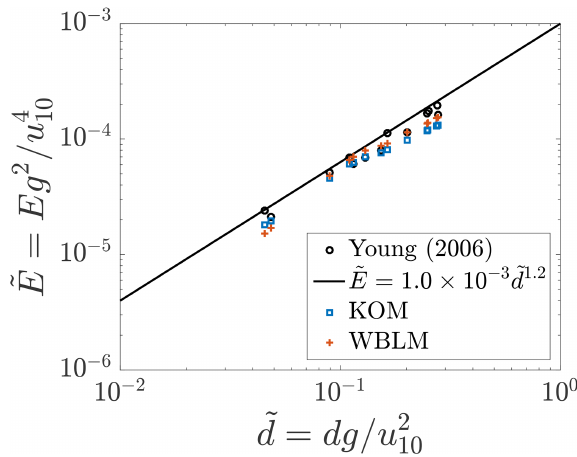
Figure 4. Observed (black circles) and parameterized (black line) non-dimensional wave energy for fully developed waves in shallow water as a function of non-dimensional depth (Young and Babanin, 2006b) and SWAN results with KOM (blue squares) and WBLM (red crosses) source terms after 24h